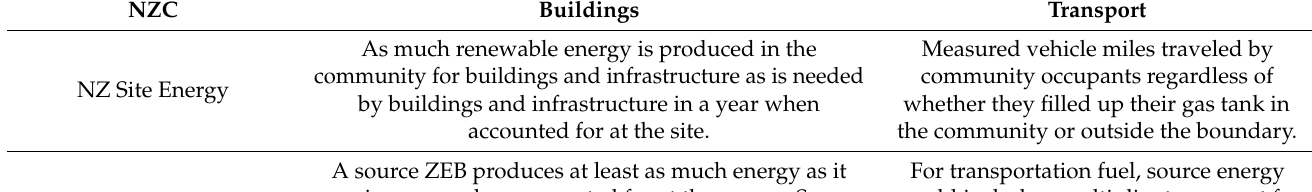
Table 2. Net zero community definition classifications. Modified from Carlisle et al. [33] at NREL (2009). NZC Buildings